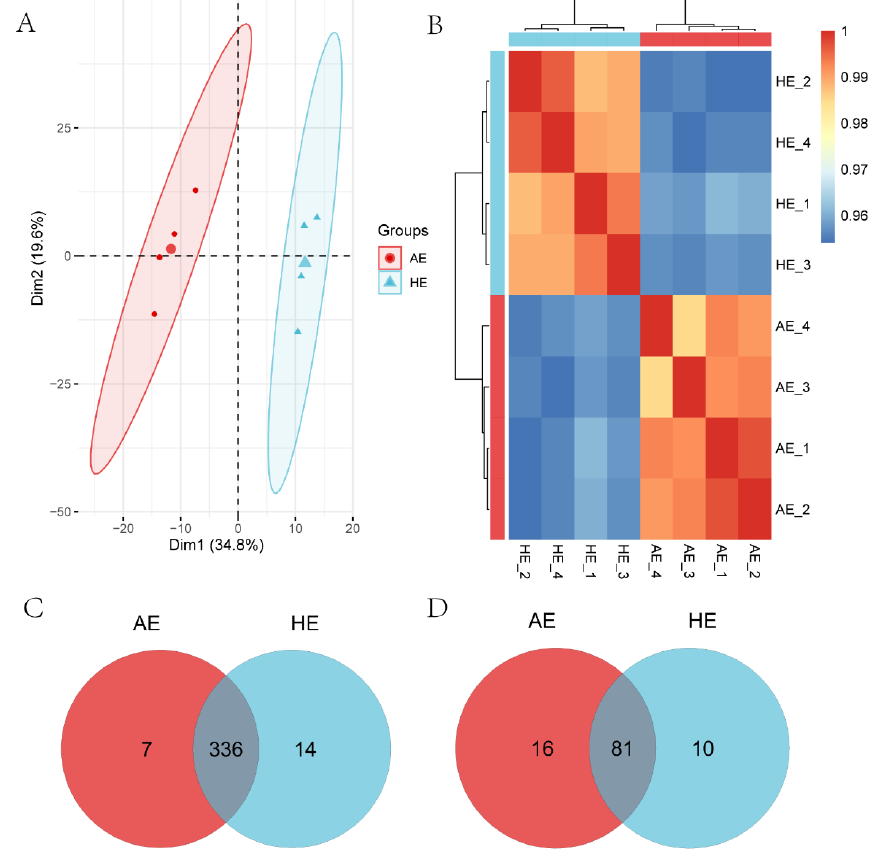
Figure 3. Correlation and miRNA expression levels in porcine endometrial samples. ( A ) Principal component analysis (PCA) between arresting endometrium (AE) and healthy endometrium (HE) samples. ( B ) Pearson correlation coefficients between samples show the correlation. The color scale is ramped up from 0.95 (blue, low correlation) to 1.00 (red, high correlation). ( C ) Venn diagrams of 357 known miRNAs in AE and HE samples. ( D ) Venn diagrams of 107 novel miRNAs in AE and HE samples.